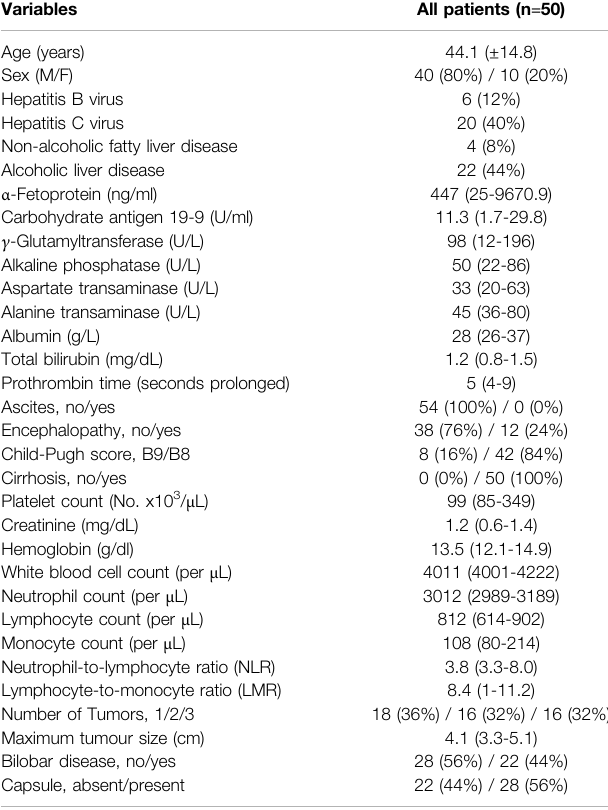
TABLE 1 | Population data. Variables All patients (n =